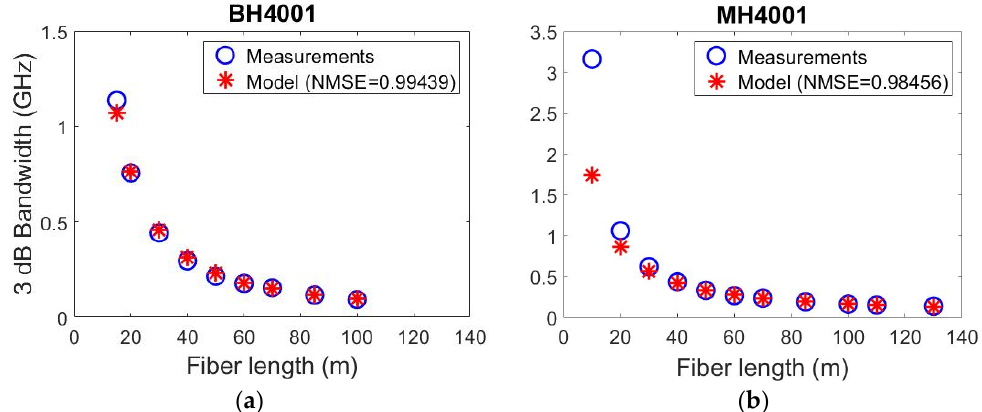
Figure 5. 3 dB bandwidth as a function of the fiber length for ( a ) BH4001 fiber and ( b ) MH4001 fiber.